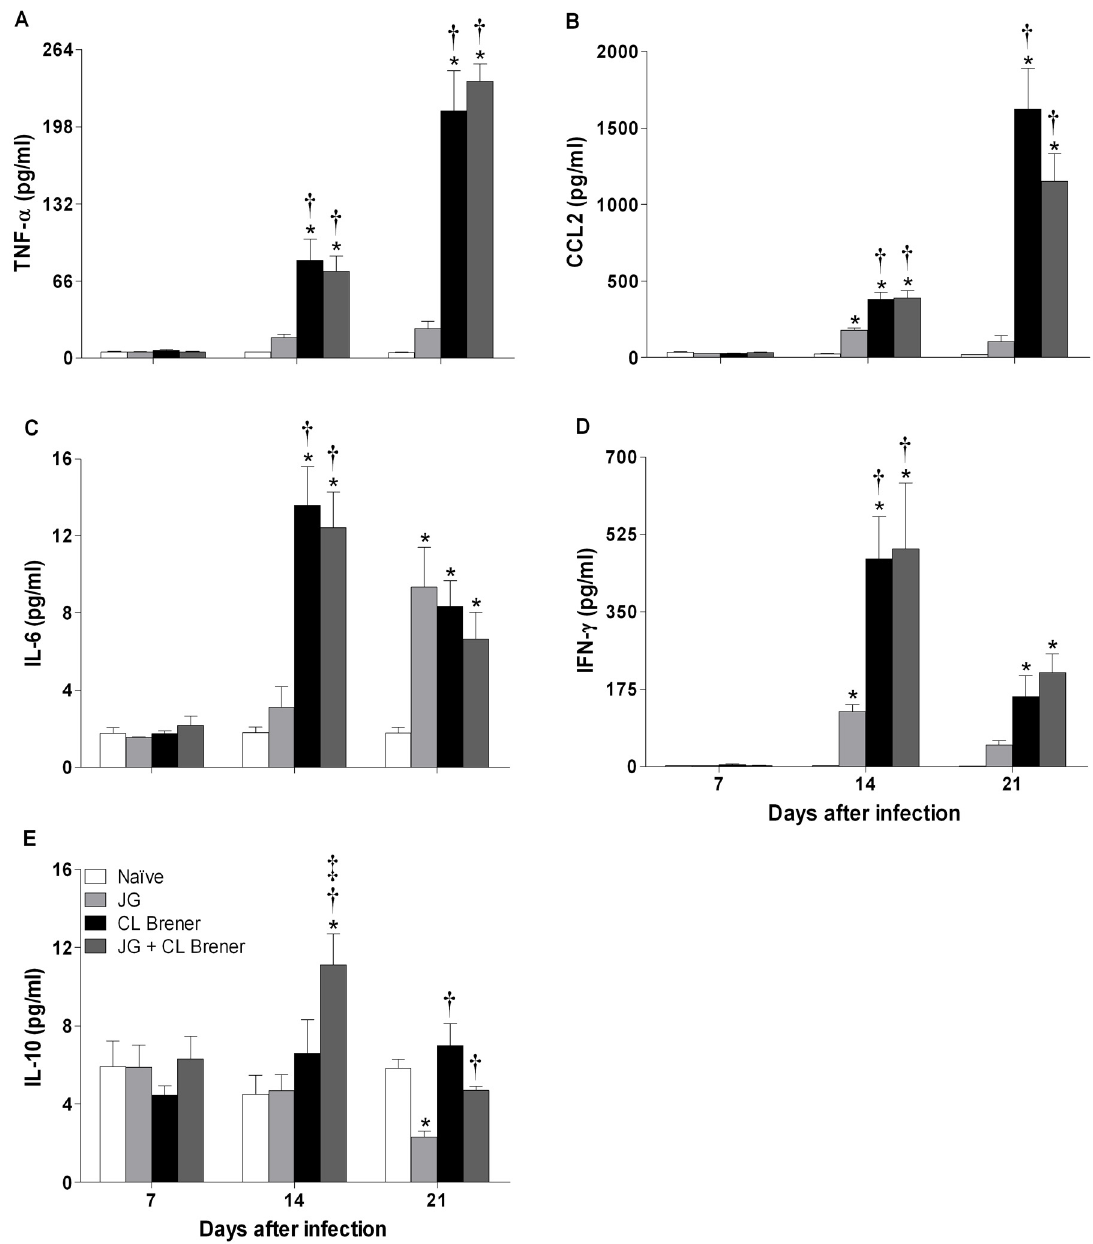
Figure 5. Serum cytokine levels in BALB/c mice infected with JG and/or CL Brener. Groups of mice were infected with 100 trypomastigotes of JG or CL Brener (single infection) or coinfected with 100 trypomastigotes of both T. cruzi populations in a 1:1 ratio via the intraperitoneal route, and serum cytokine levels were assessed at 7, 14 and 21 days p.i. Symbols as follows: (A) TNF- a ; (B) CCL2; (C) IL-6; (D) IFN- c ; (E) IL-10; white bar: Naı¨ve mice; light gray bar: JG infected mice; black bar: CL Brener infected mice; and dark gray bar: JG and CL Brener infected mice. Values are expressed as the mean 6 SEM of three mice per group (representative of two independent experiments). *, { and { represent P , 0.05 compared with naı¨ve, JG and CL Brener mouse groups,